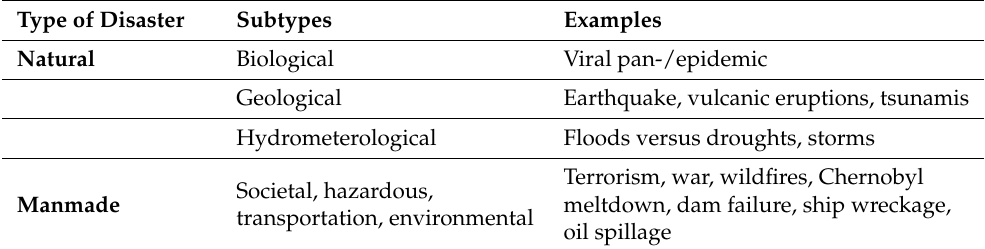
Table 1. Classification of